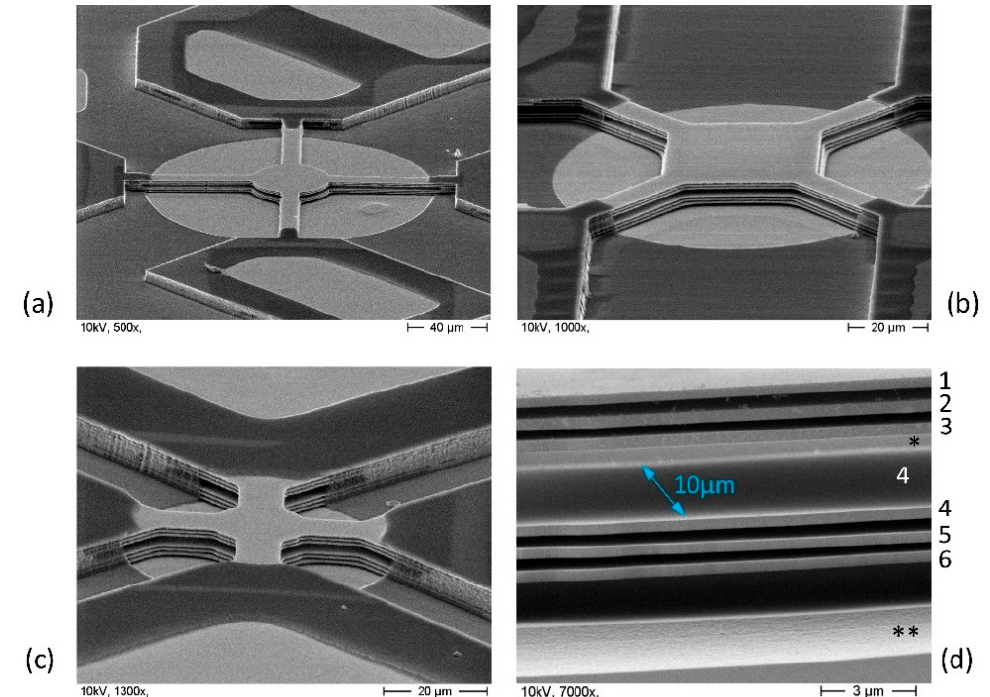
Figure 14. SEM micrographs of InP/InGaAs multiple air-gap MEMS tunable FP filters. Each DBR consists of three InP layers and two air-gaps. ( a ) 60 µm long suspensions and a circular membrane with 40 µm diameter. ( b ) Square membranes. ( c ) Short suspensions and small membranes. ( d ) Details of the suspension region. It allows a view through the structure to the ground behind marked with “*”. The ground level in front is marked with “**”.